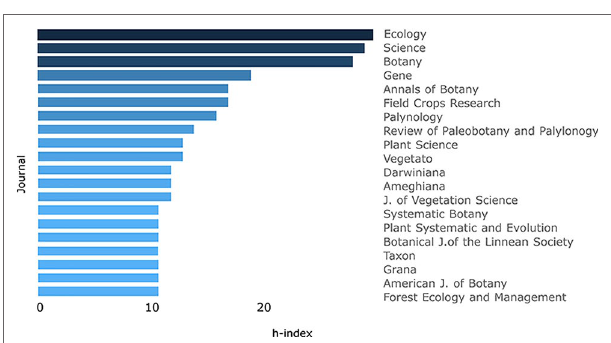
FIGURE 3 | Journal’s impact (h-index) of the first 20 journals chosen to publish herbaria-based-research, based on the bibliometric analysis of publications stored at Scopus database from 1993 to 2018 (refer to the text to see filters of the search).